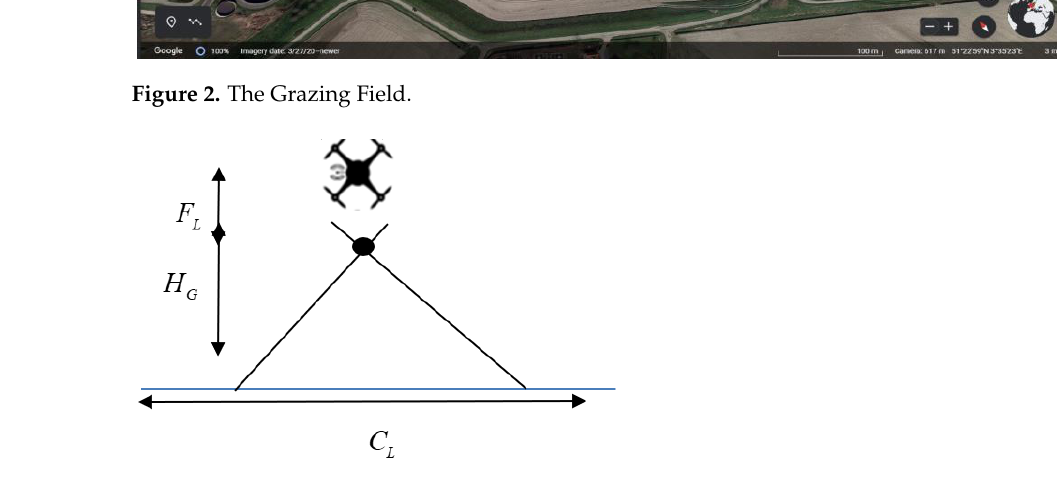
Figure 2. The Grazing Field.